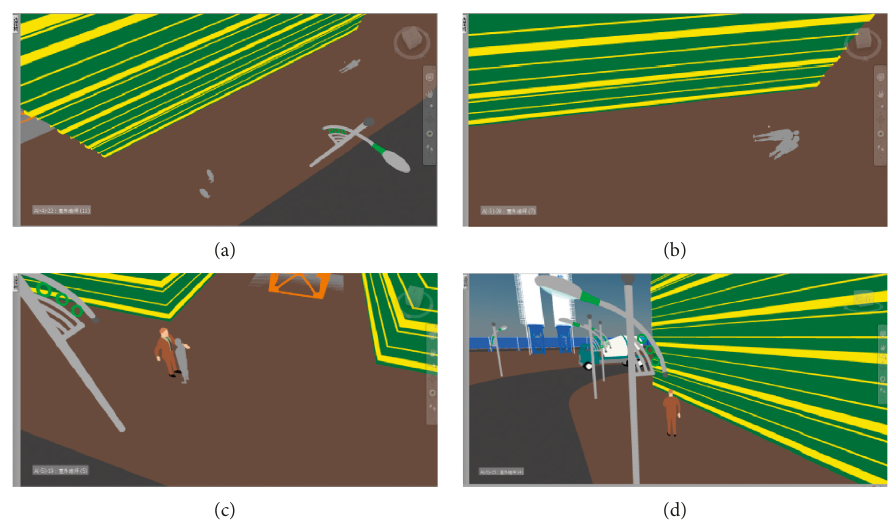
Figure 9: Schematic diagram of the accident animation simulation.